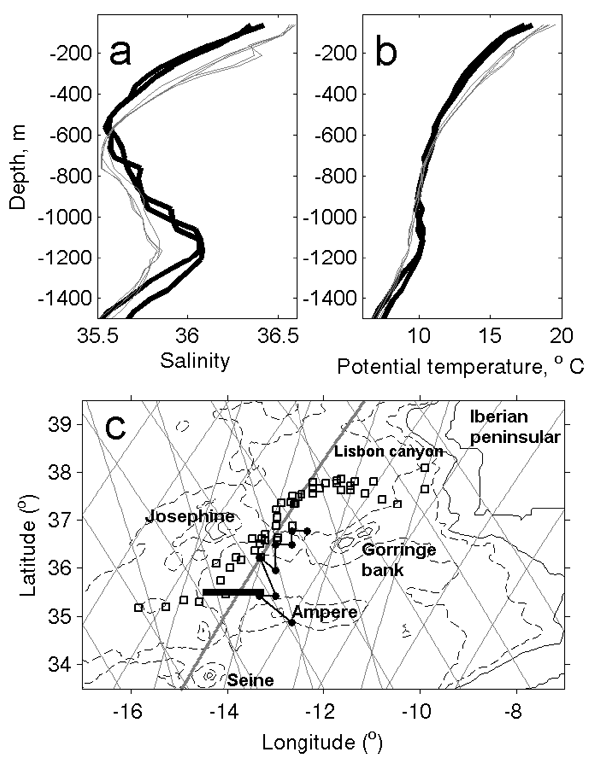
Fig. 1. Vertical profiles of (a) salinity and (b) potential temperature obtained near Seine seamount in July 2004. Thick black lines are the casts through a meddy, and thin grey lines are the casts around the meddy. (c) Area of study with topographic contours of 0 and 1000m (solid black lines), 2000 and 4000m (dashed black lines); some bathymetry features are identified. Straight grey lines present altimetry tracks crossing the study region during a 10-day period centred on 20 August 2010. The Jason pass 137 is marked with a thicker line. The trajectory of Meddy 1 (black line with filled-in circles) and surfacing positions of an Argo float when trapped in Meddy 2 (squares) are